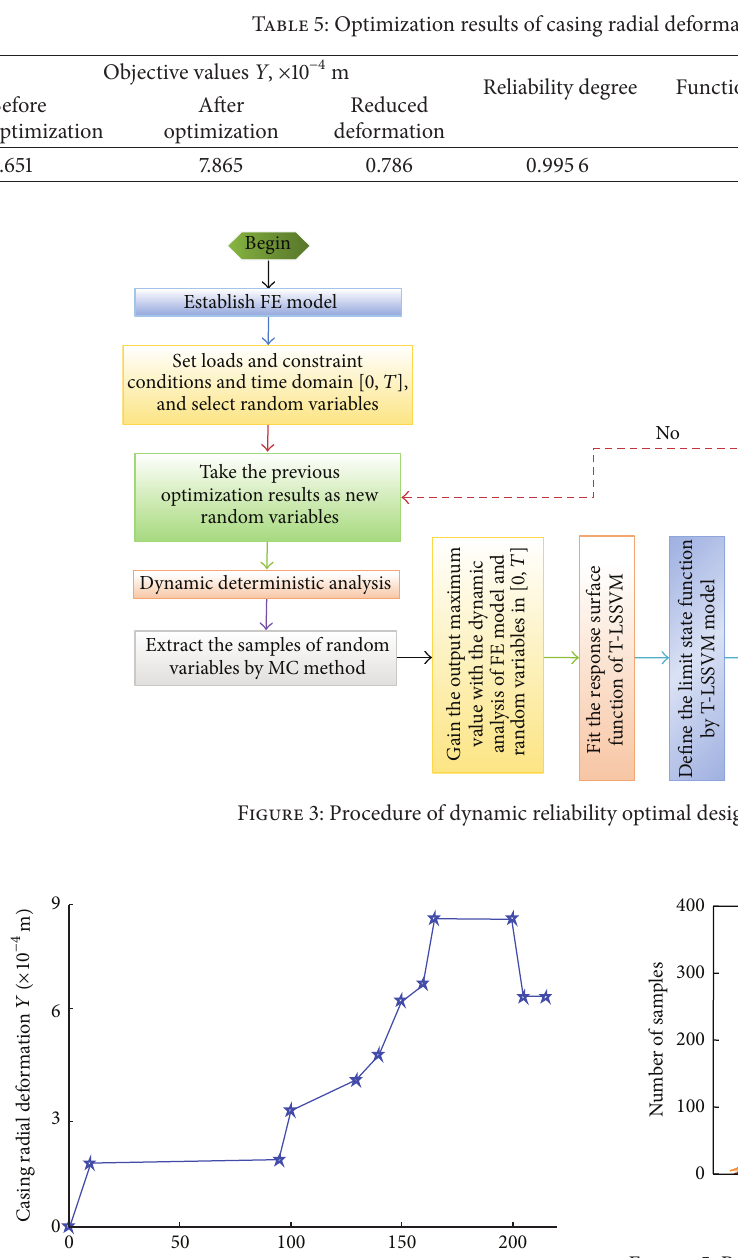
Figure 5: Probability distributions of maximum output response 𝑌 ( × 10 −4 m) before and after optimization. of maximum output response 𝑌 before and after optimization were shown in Figure 5. From the optimization, the optimal solution of T-LSSVM is x ∗ = (3 × 10 −3 , 1 034.3, 5 910, 1.851, and 27.73). The objective values, computational accuracy, optimal time, iterations, and function counter are drawn in Table